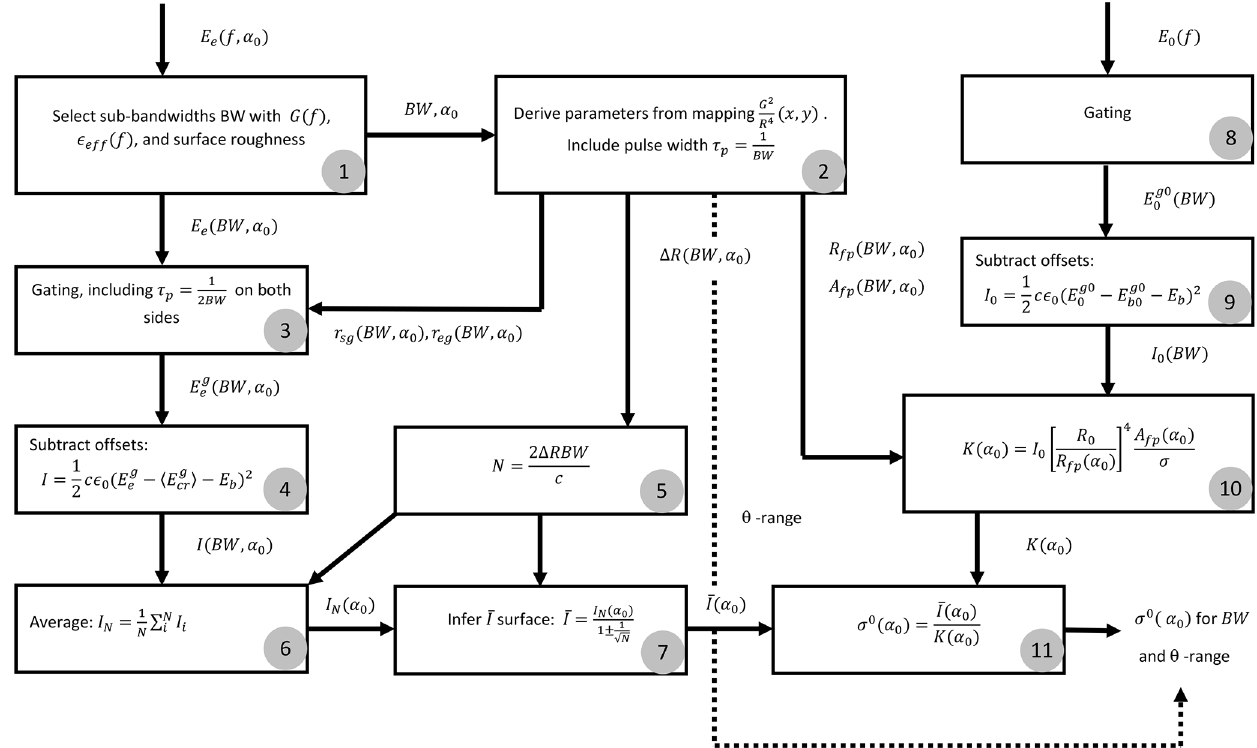
Figure 4. Flow chart of σ 0 derivation process. Inputs are the measured backscattered electric fields of the surface target E e ( f,α 0 ) and the calibration standard E 0 ( f ). The process follows from 1 to 11 in